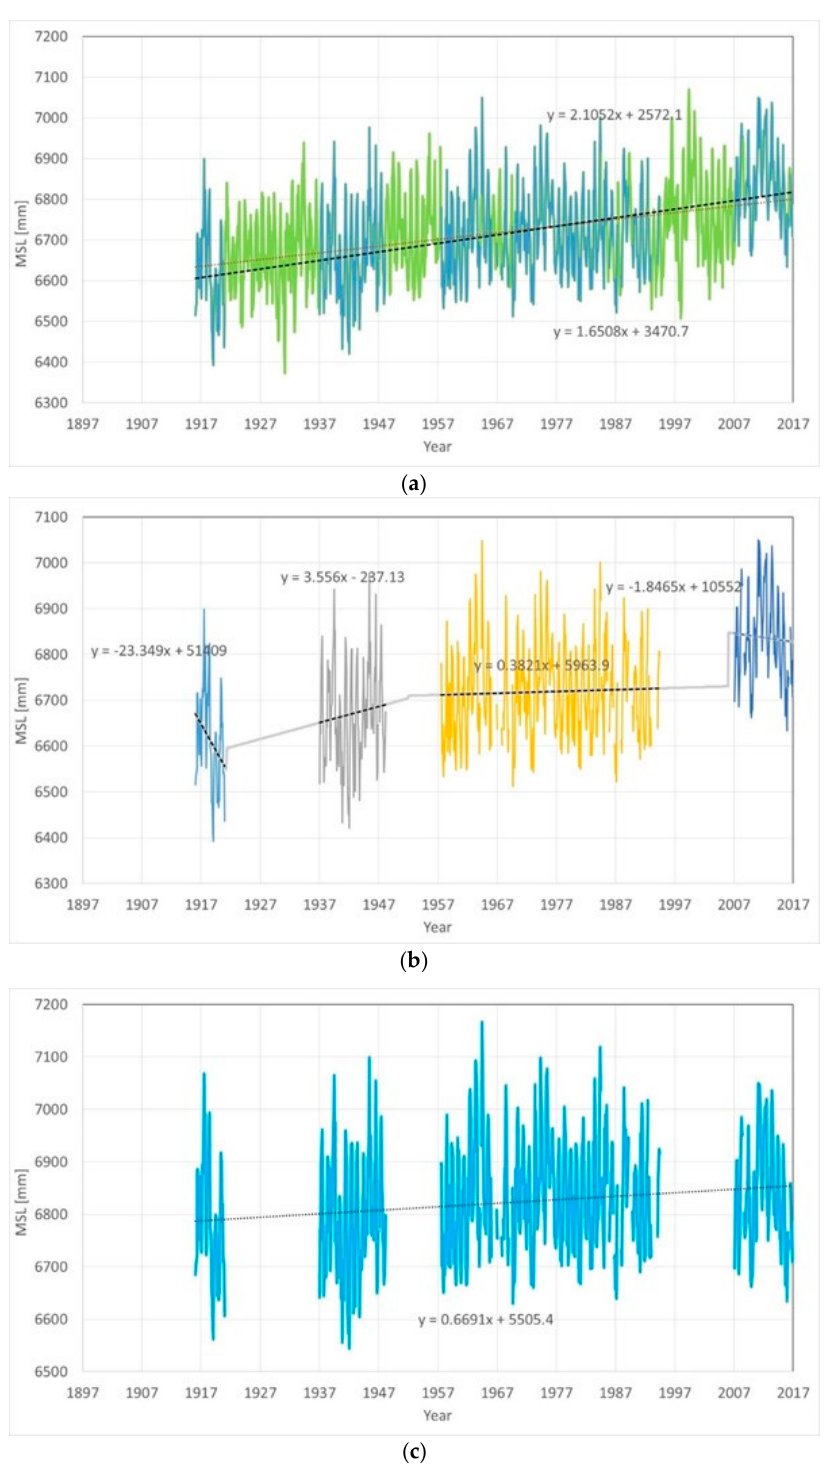
Figure 13. MSL of Fremantle with the same gaps in Karachi. ( a ) The effect of the gaps. ( b ) Breakpoints alignments. ( c ) Aligned series with gaps.